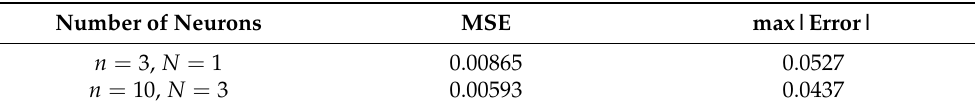
Table 3. Results of PBA-PINN learning. The mean square error (MSE) and the maximum value of the absolute error for PBA-PINNs (23) with N neurons per first hidden layer and n neurons per second one after learning by minimising the loss (21).